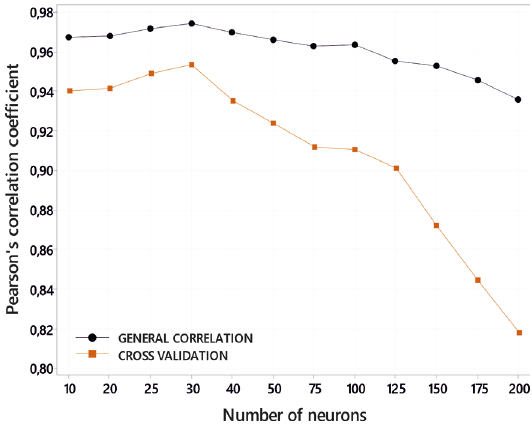
Figure 8. Model validation general correlation e cross